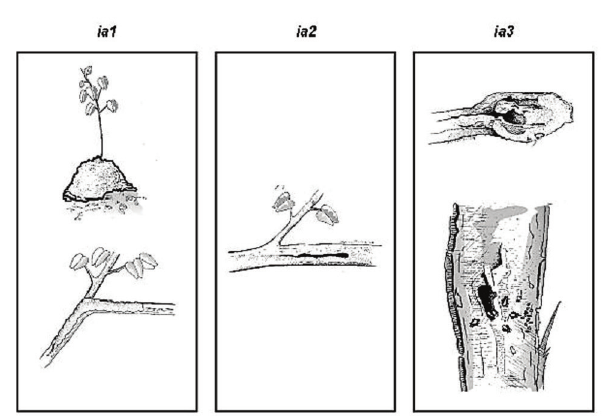
Fig 1. Schematic illustration of the categories of intensity of attack ( ia ) by termites on plants of Cerrado in the Estação Ecológica de Pirapitinga - Minas Gerais. ia1 - Presence of termites with no attack – termite nests constructed around a plant stem, but without evidence of attack or gallery construction. ia2 - Attack limited to the bark - gallery construction on a branch. displaying the damage to the bark. ia3 - Severe attack - transversal section of one trunk severely damaged in its internal structure and still with presence of termites.